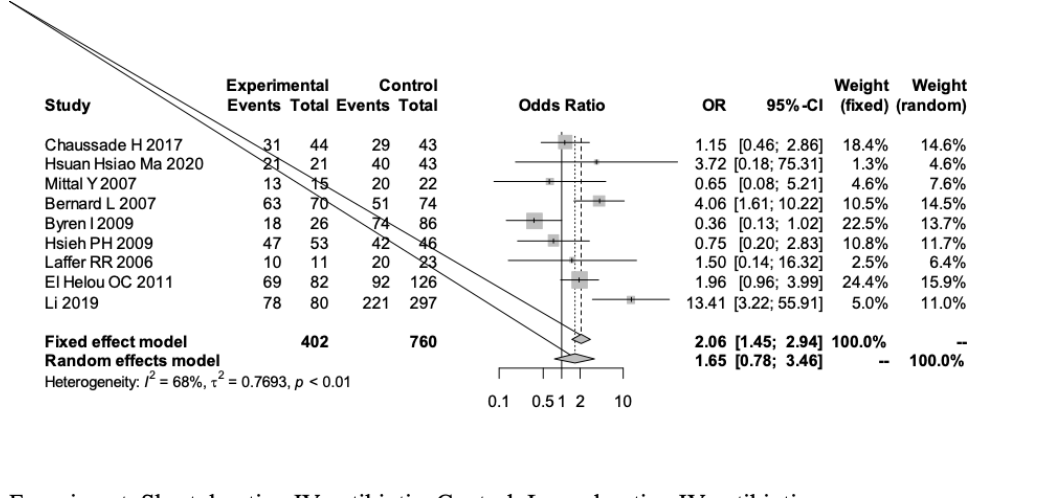
Figure 2. A forest plot outlining the overall success rate of the short-duration (experimental) and long-duration (control) IV antibiotic treatments in THA- or TKA-related PJI.